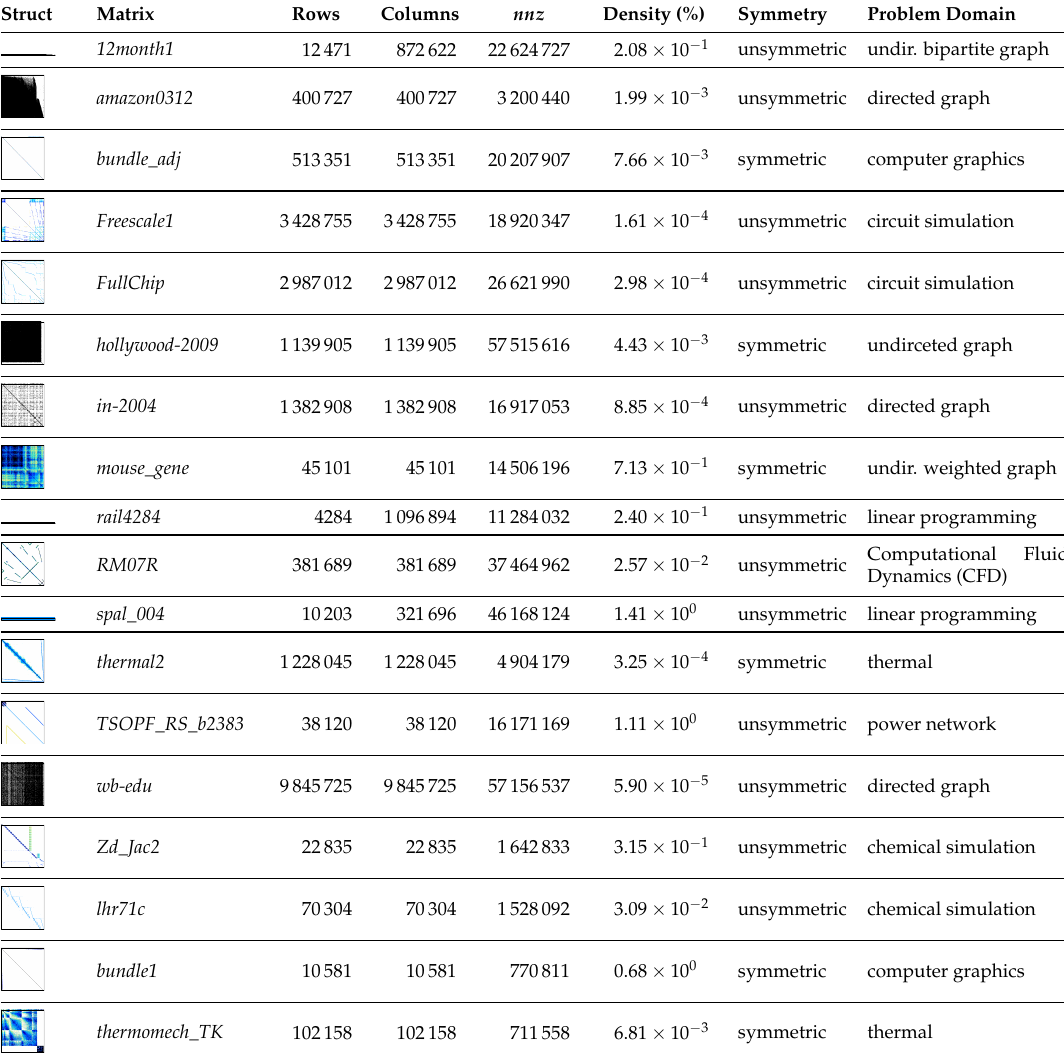
Table 3. Benchmark dataset: 26